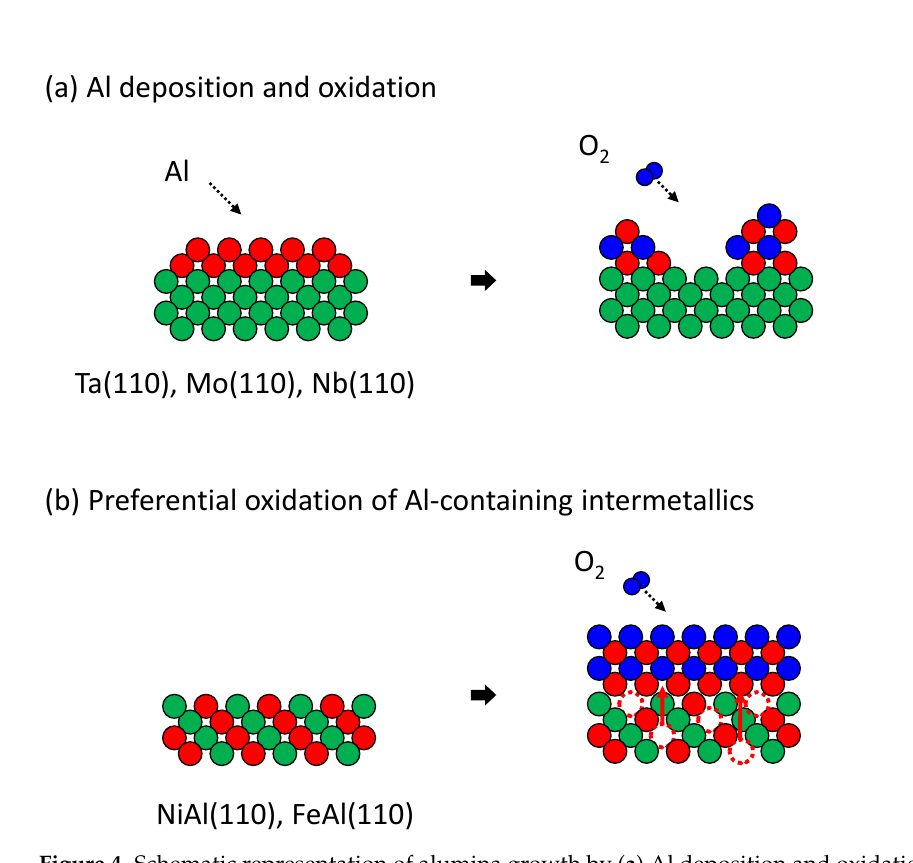
Figure 4. Schematic representation of alumina growth by ( a ) Al deposition and oxidation on high- melting-temperature bcc metal (110) surfaces, and ( b ) preferential oxidation of (110) surface of Al-containing intermetallics having bcc-like structure.